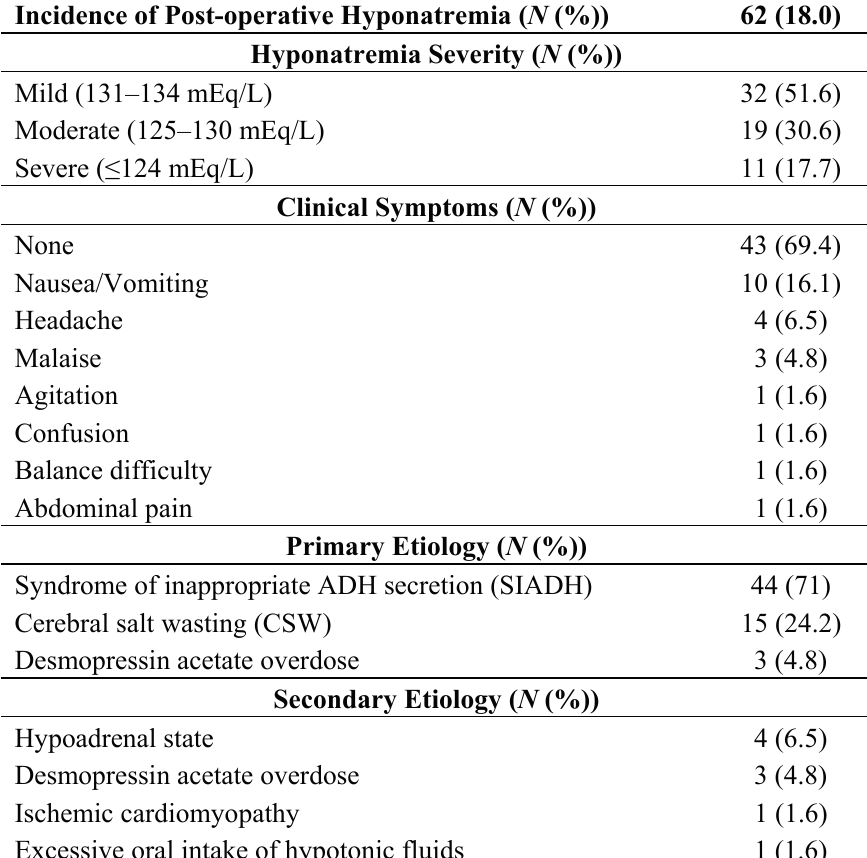
Table 3. Incidence, clinical symptomatology and etiologies of postoperative hyponatremia in 344 consecutive patients who underwent transsphenoidal resection of a pituitary mass at the authors’ institution between January, 2006, and December,